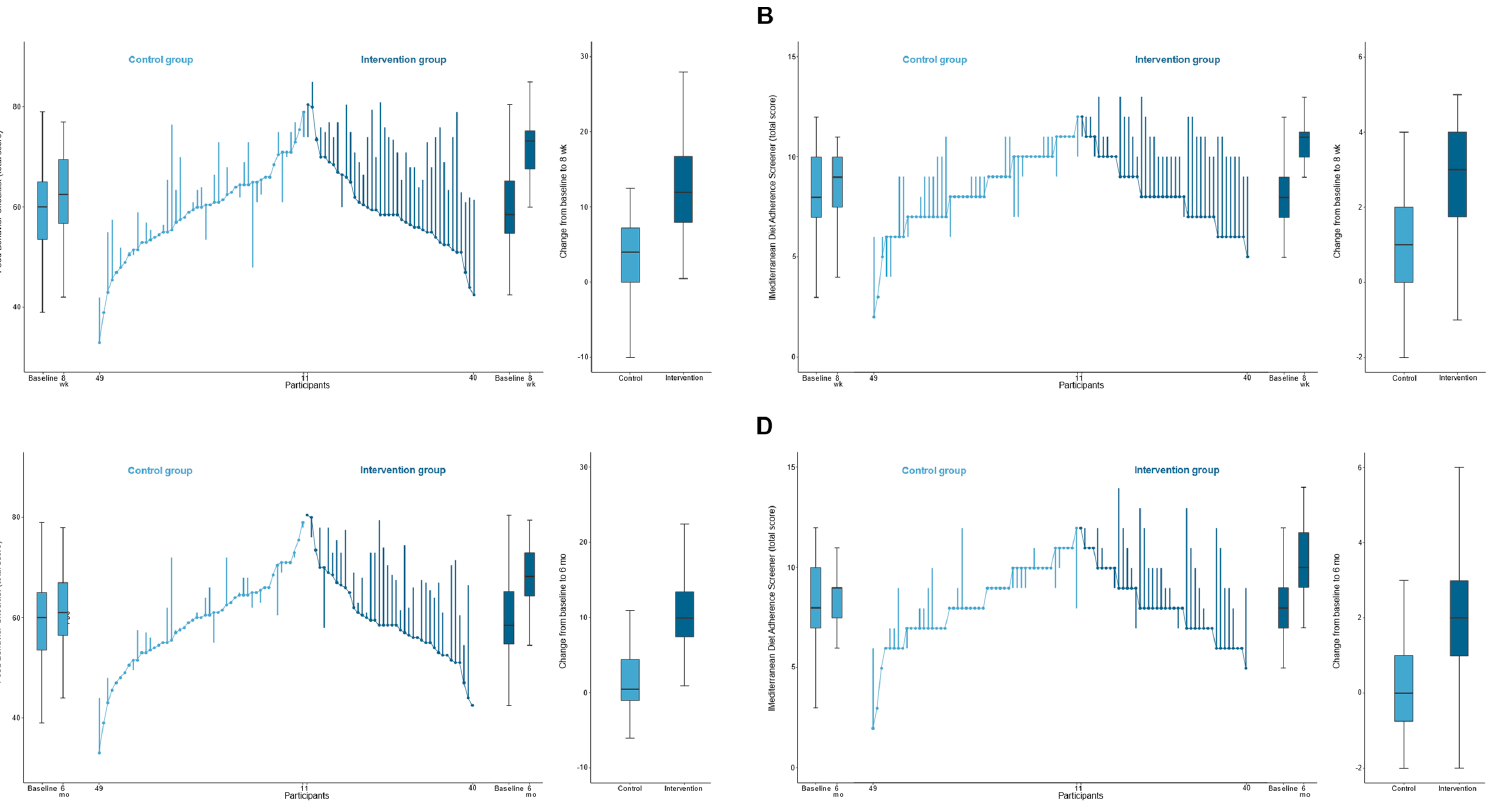
Figure 2. Dietary behavior outcomes. The ends of the boxes in the boxplots are located at the first and third quartiles, with the black line in the middle illustrating the median. Whiskers extend to the upper and lower adjacent values, the location of the furthest point within a distance of 1.5 interquartile ranges from the first and third quartiles. The parallel line plot contains 1 vertical line for each patient, which extends from their baseline value to their 8-week value ( A , B ) or 6-month value ( C , D ). Ascending lines indicate an improvement in the outcome. Baseline values are placed in ascending order for the control group and descending order for the intervention group. ( A , C ), The Food Behavior Checklist assesses dietary behavior (range, 23–85; higher scores indicate healthier dietary behavior) [45]. ( B , D ), The Mediterranean Diet Adherence Screener assesses adherence to the Mediterranean diet (range, 0–14; higher scores indicate greater adherence; scores ≥ 10 indicate high adherence to the Mediterranean diet) [46].